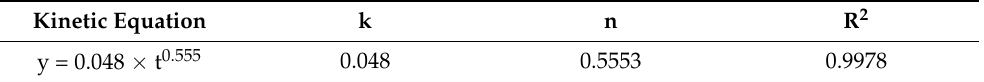
Table 2. Kinetic parameters for CrN x -coated 310 H SS samples in supercritical conditions. Kinetic Equation